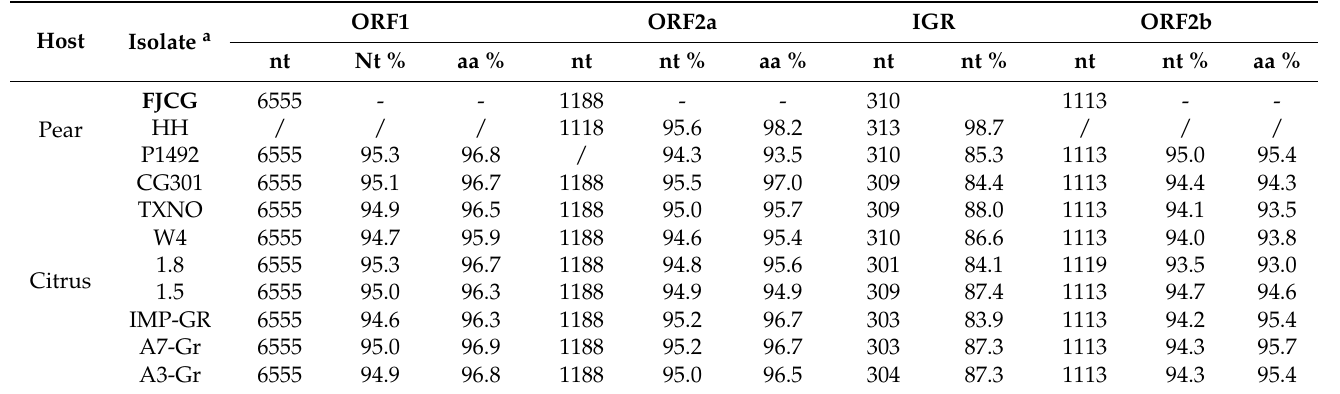
Table 3. RNA sequence comparison of CiVA from two Chinese pear samples with that of reported CiVA